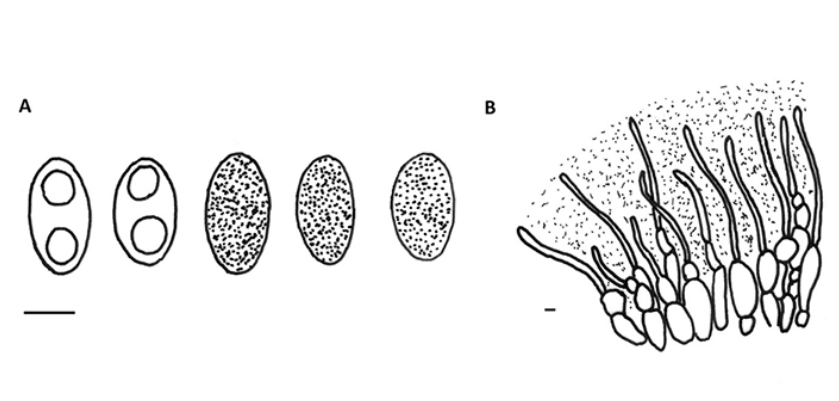
Figure 3 Microcharacters of Pachyella violaceonigra (Rehm) Pfister: ( A ) spores, ( B ) ectal excipulum with a gelatinous layer. Scale bars: 10 µ